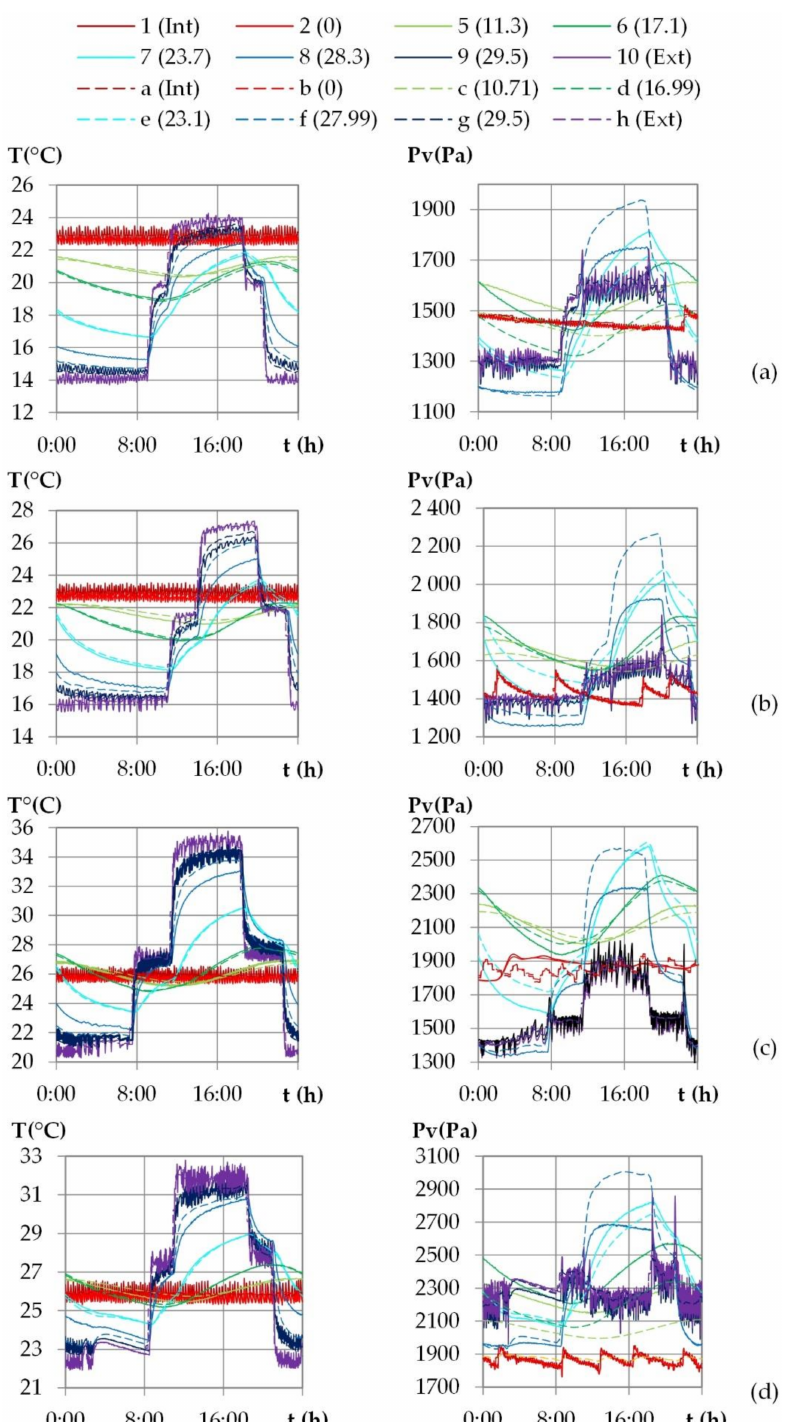
Figure 12. Variation of temperature and vapor pressure within the wall during the last stabilized cycle for the climate of: ( a ) Rennes, ( b ) Toulouse, ( c ) Kairouan, ( d ) Djerba. Experimental results: continuous lines; numerical results: dotted